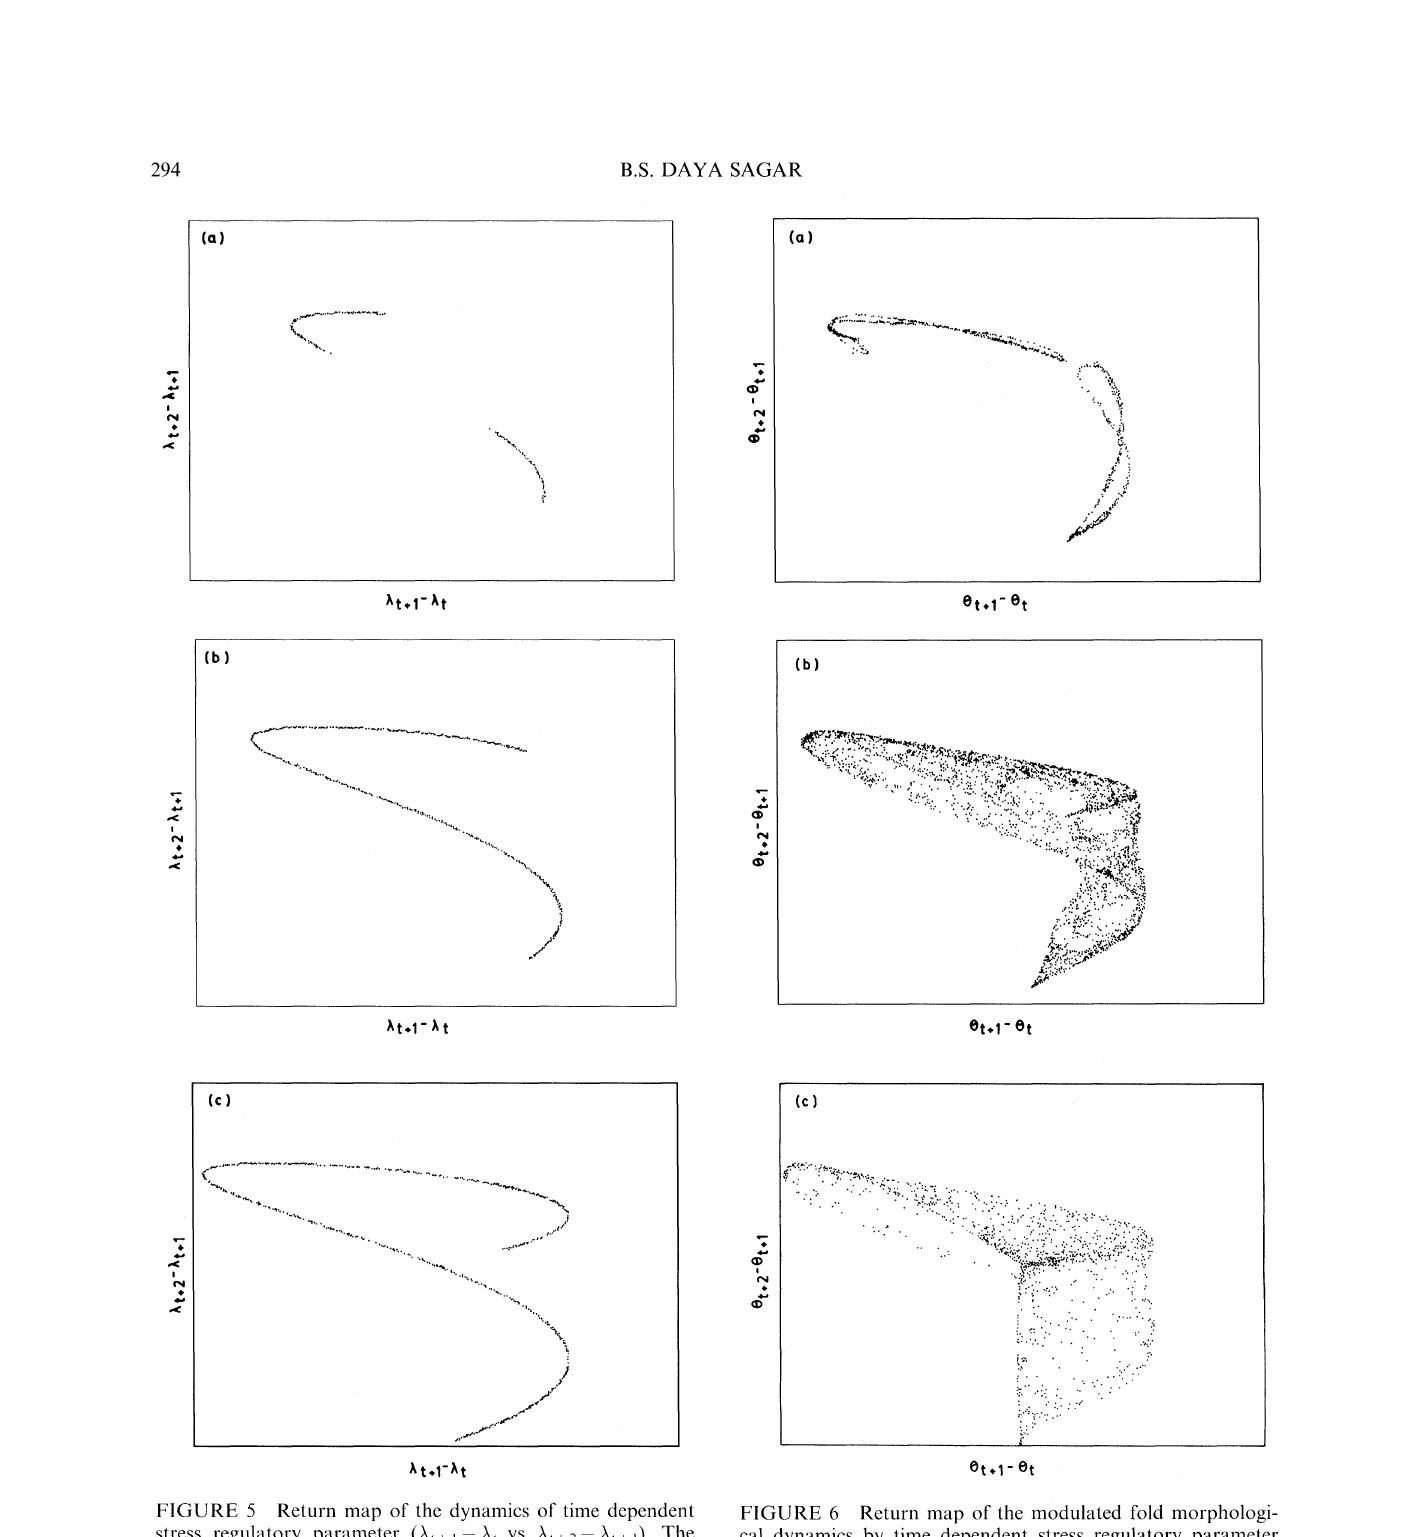
FIGURE 6 Return map of the modulated fold morphologi- cal dynamics by time dependent stress regulatory parameter 0 vs 0 + -0 + 1). The control parameter (a) # 0.9, (0 t+ (b) 0.95 and (c) 0.9925. The specifications for the simulation are’ A=0.00001, 0= 179.43028 or c=0.00001 and iteration no. 10 106 time steps. This map is plotted in 0-parameter